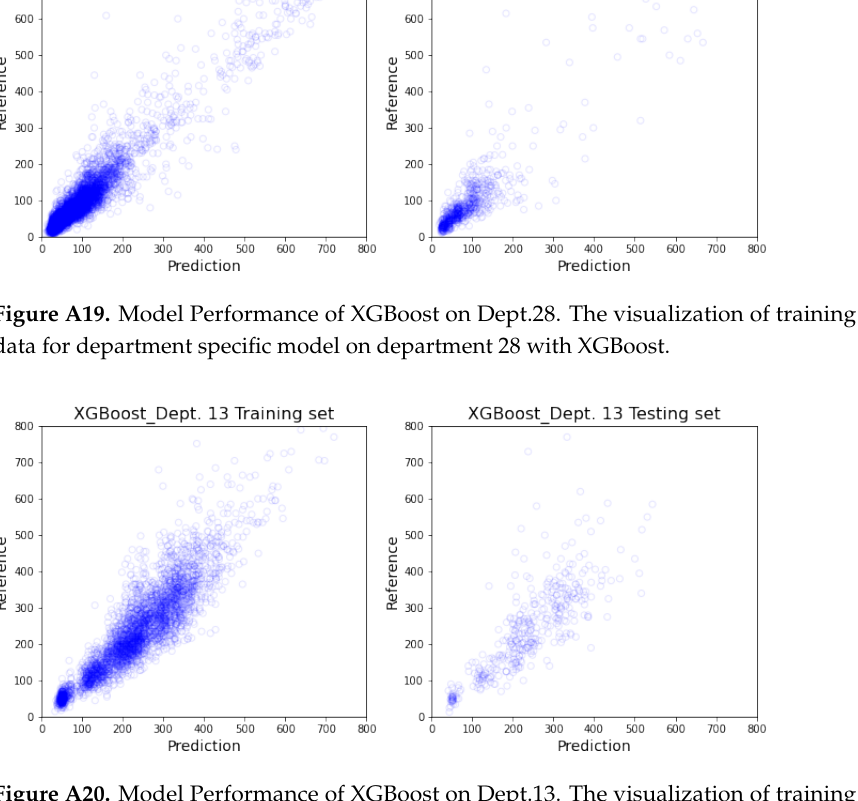
Figure A20. Model Performance of XGBoost on Dept.13. The visualization of training and testing data for department specific model on department 13 with XGBoost.